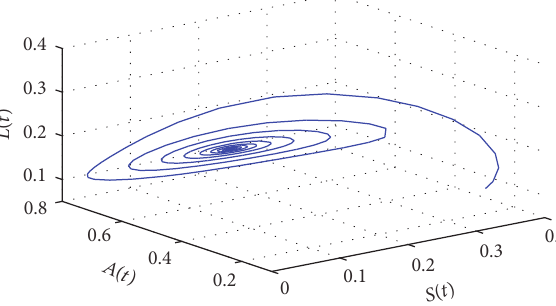
Figure 10: The phase plot of states 𝑆 ∗ , 𝐿 ∗ , and 𝐴 ∗ with 𝜏 = 21.35 < 24.2508 = 𝜏 0 .